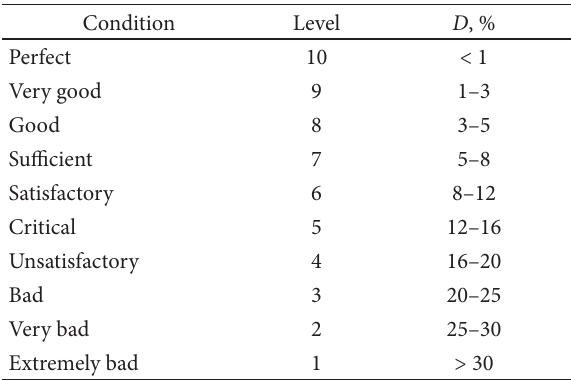
Table 1. Condition of HMA pav ement according to